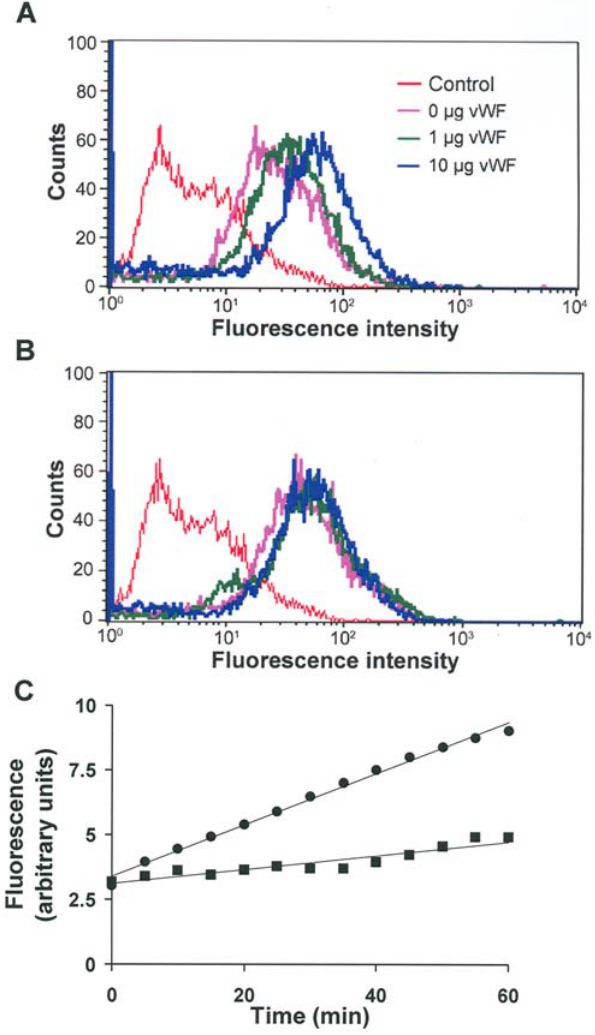
Figure 6. The pAb BL154G inhibits VWF-induced conforma- tional changes in ADAMTS13. (A) ADAMTS13 was incubated with increasing concentrations of VWF for 30 min at 37 u C followed by the addition of the pAb BL154G. (B) ADAMTS13 was incubated with BL154G antibody for 30 min at 37 u C. Increasing concentrations of VWF were then added to the samples. Both sets of samples were analyzed by flow cytometry. Histograms represent binding of mAb in the presence of 0 (red), 100 (purple), 250 (green) and 500 (blue) m l of VWF stock. The N figures represent data from one of three independent experiments. (C) ) and presence ( & ) of the pAb, Activity of ADAMTS13 in the absence ( BL154G, measured using the FRETS-VWF73 assay.